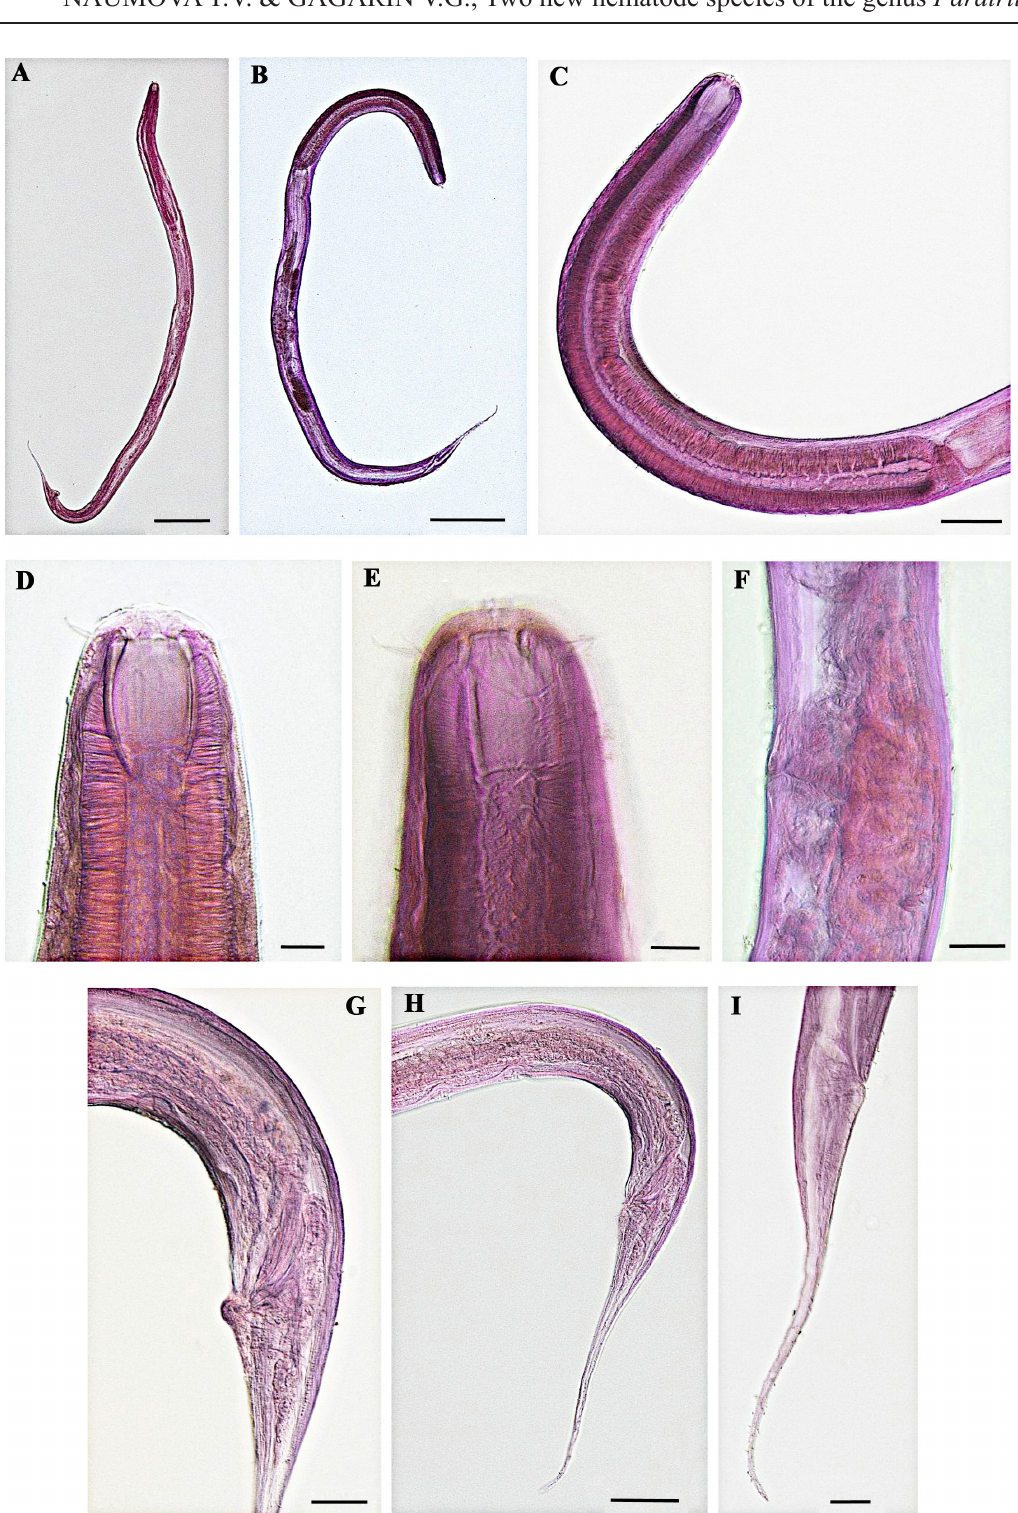
Fig. 4. Paratrilobus aquaticus sp. nov., light micrographs. A . Entire male. B . Entire female. C . Female pharyngeal region. D . Male anterior end. E . Female anterior end. F . Female vulva region. G . Male cloacal region. H . Male posterior body end. I . Female posterior body end. A, D, G–H: holotype (HM RAS 102/64 768-2); B–C, I: paratype (HM RAS 102/64 768-4); E–F: paratype (LIN-SB 765-3). Scale bars: A–B = 200 µm; C, H = 50 µm; D–E = 10 µm; F–G, I = 20